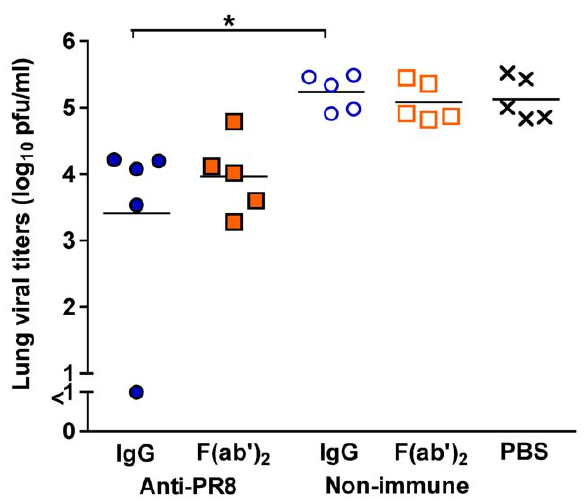
Figure 5. Virus loads are reduced but by a lesser extent if Ab treatment is delayed. BALB/c mice were infected with 50 pfu of PR8 virus in 50 m l via the TRT route under penthrane anaesthesia. Two days post-infection, mice were treated with 1 mg of the Ab preparations or PBS via the TRT route. Five days post-infection, mice were killed and lungs were collected in 1 ml media. Viral titres were determined by plaque assay on MDCK cell monolayers. The experiment was performed once with 5 mice per group, the organs assayed in quadruplicate and titers averaged to provide a value for that animal. Each symbol represents an individual mouse and the line represents the mean of each group. Brackets with an asterisk indicate a statistically significant difference between the indicated groups.